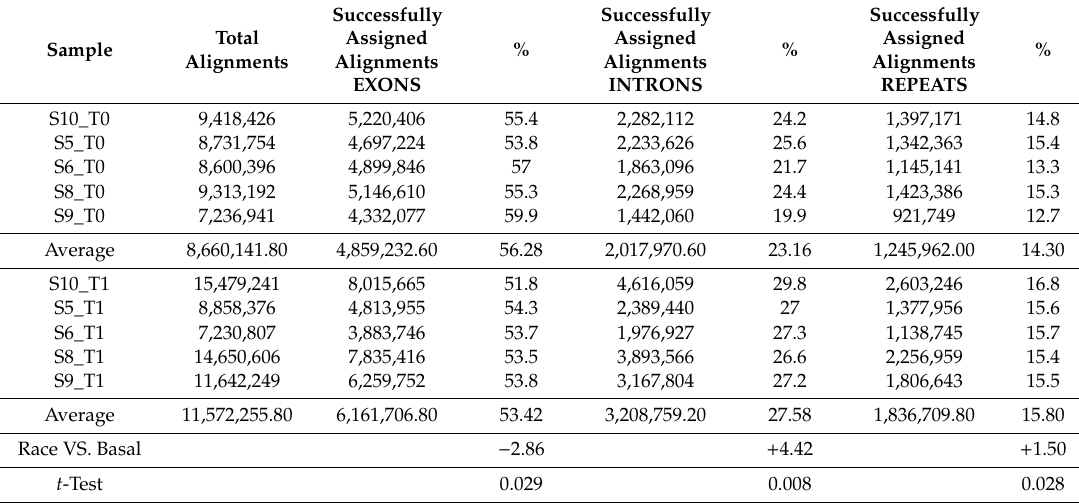
Table 2. Reads alignment on genomic